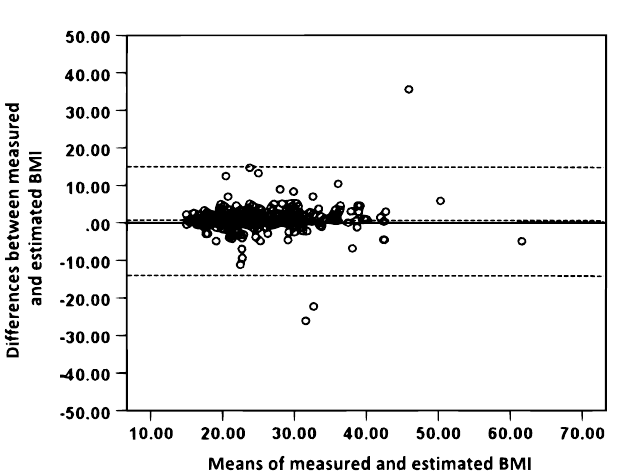
Figure 2. Bland and Altman levels of agreement plot for the actual and calculated BMI from self-reported weight and height. The centered dotted line represents the mean differences or bias (0.478 kg/m 2 ) and the outer doted lines represent the upper (17.5 kg/m 2 ) and lower (− 17.0 kg/m 2 ) 95% of limits of agreement.